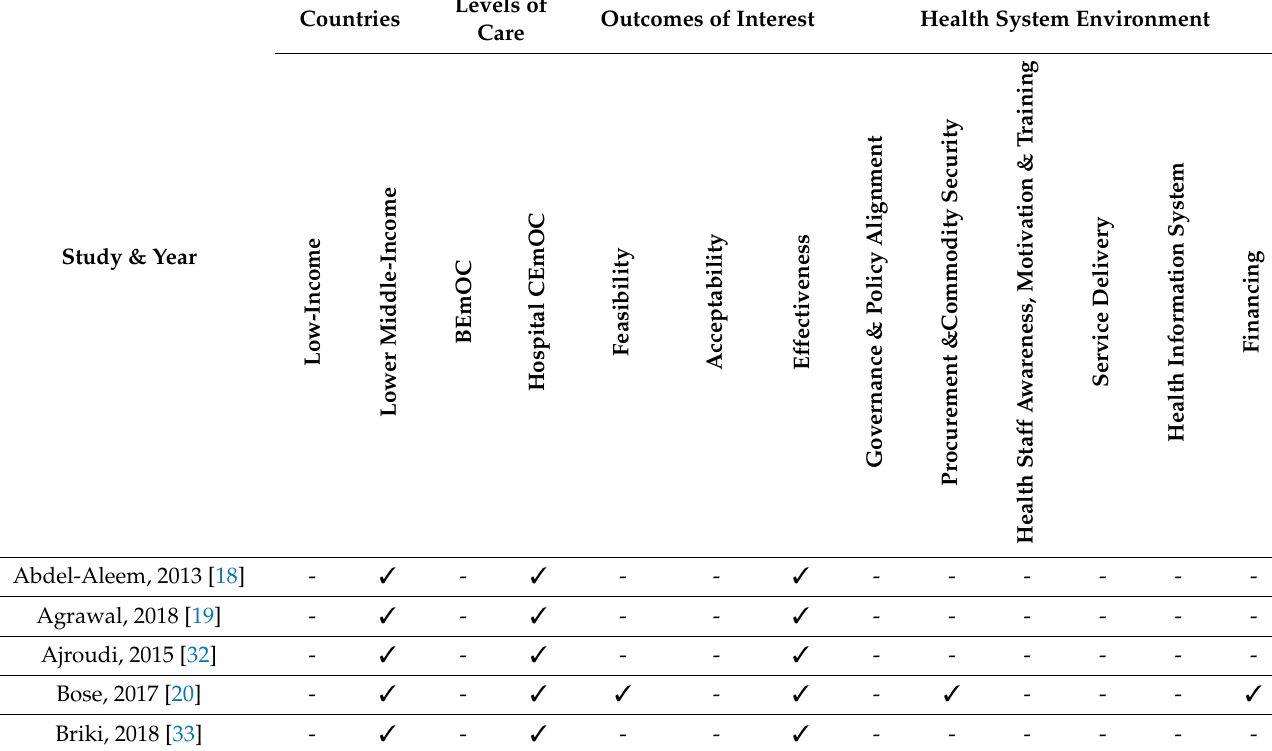
Table 4. Contexts and main concepts of included